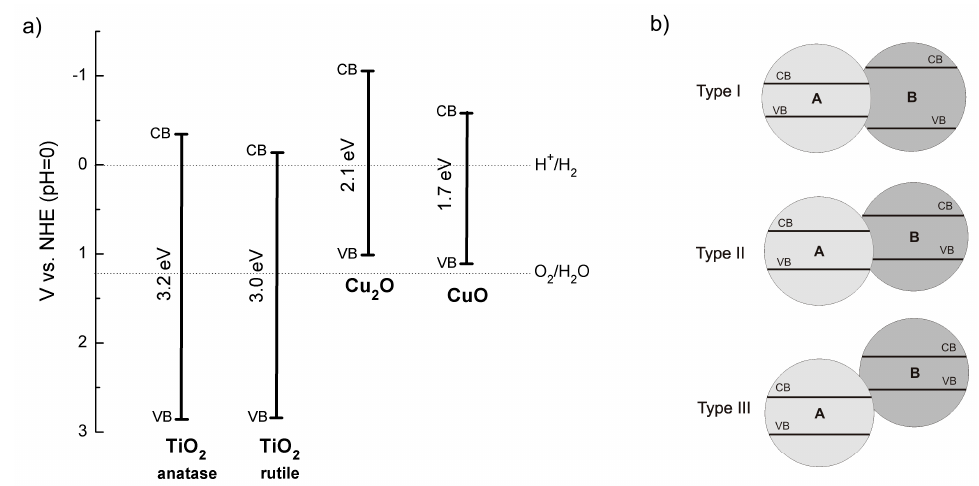
Figure 4. ( a ) Band gap energies and band positions of titania (anatase and rutile) and copper oxides—values of band positions were taken from the reference. Data collected from [71]; ( b ) Types of heterojunction system of coupled semiconductors.